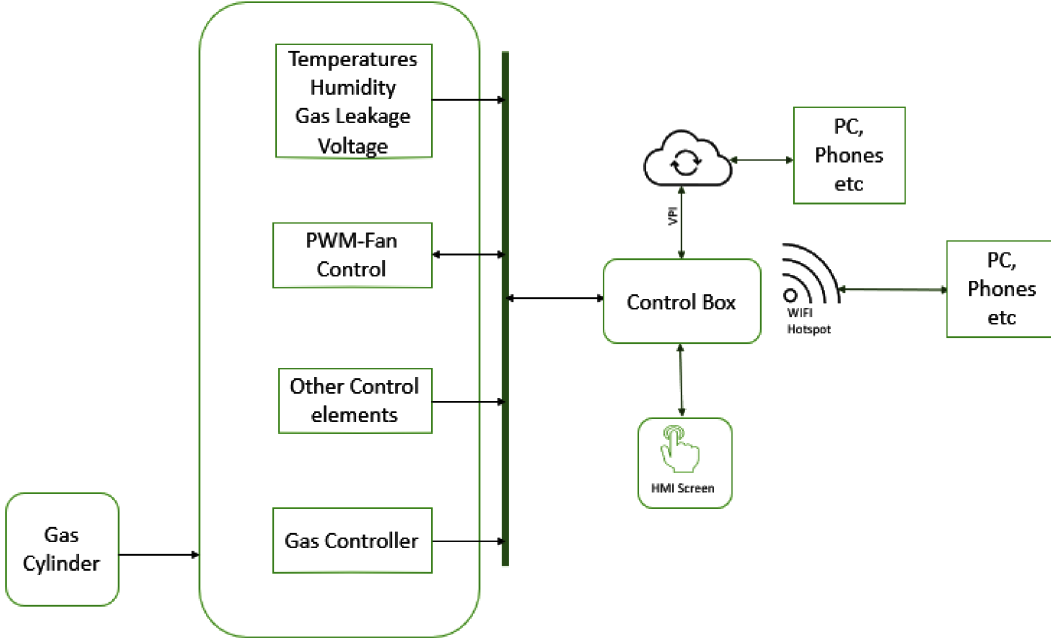
Figure 1. Block diagram of proposed